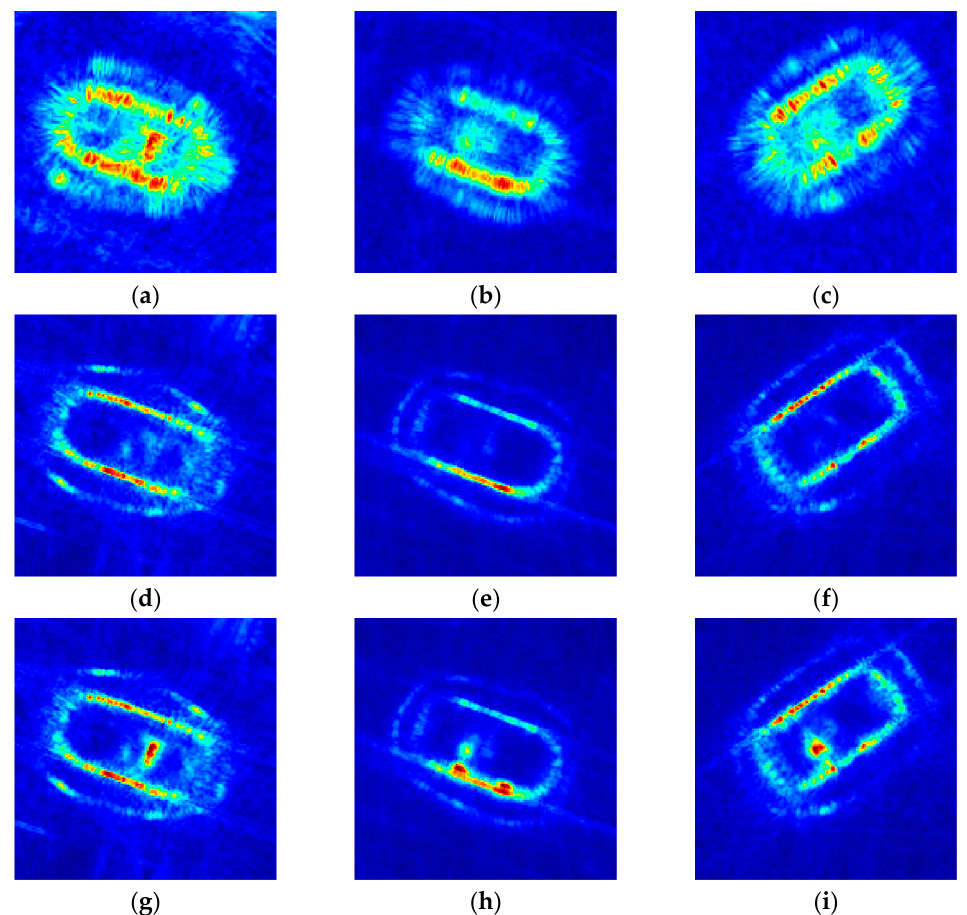
Figure 6. Comparison of I org , I thin and I fin images of the three vehicle models of Chevrolet Impala LT, Mitsubishi Galant ES, and Toyota Highlander in Figure 1a–c: ( a – c ) I org images of three vehicle models;